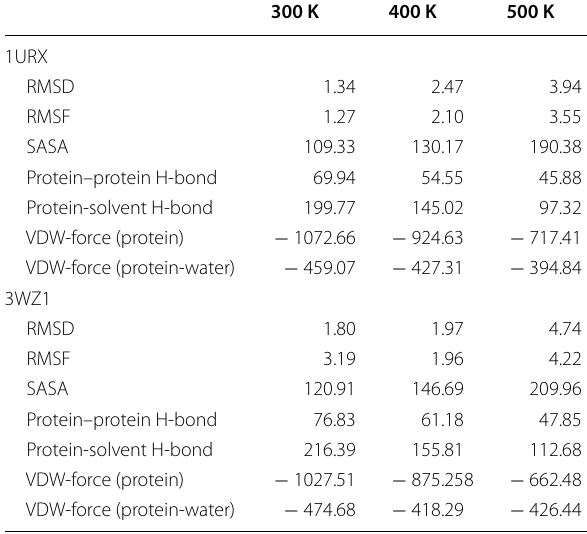
SASA, H-bonds, VDW-force denote solvent accessible surface area, hydrogen bonds and Van Der Waals force, respectively. The values of SASA and VDW-force are given in Å and kcal/mol